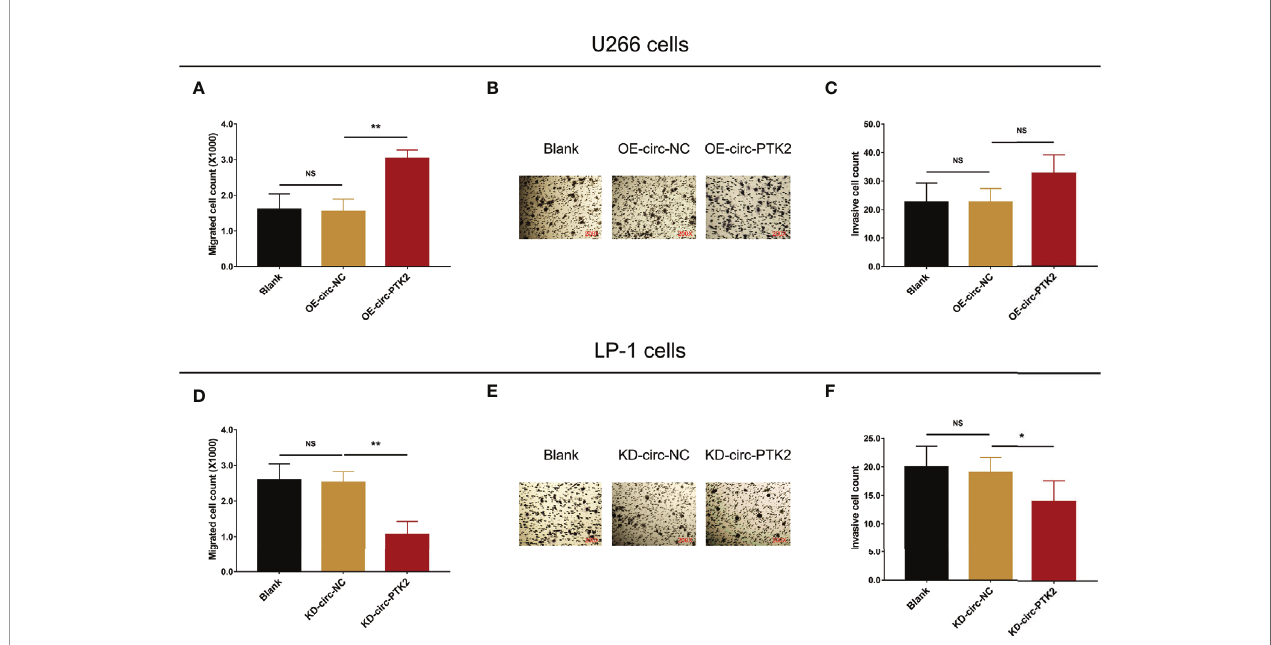
FIGURE 3 | Circ-PTK2 promoted migration but not invasion of MM cells. The effect of circ-PTK2 overexpression plasmid transfection on cell migration (A) and invasion (B, C) were detected by Transwell migration and invasion assays in U226 cells. The effect of circ-PTK2 knock-out plasmid transfection on cell migration (D) and invasion (E, F) were detected by Transwell migration and invasion assays in LP-1 cells. Circ-PTK2, circular RNA protein tyrosine kinase 2; MM, multiple myeloma; NS, non-signi fi cant; OE-circ-NC, circRNA control overexpression; OE-circ-PTK2, circ-PTK2 overexpression; KD-circ-NC, circRNA control knock-down; KD-circ-PTK2, circ-PTK2 knock-down; * P < 0.05; ** P < 0.01. Experiments were performed in triplicates. The comparison was determined by One-way ANOVA followed by Dunnett ’ s multiple comparison